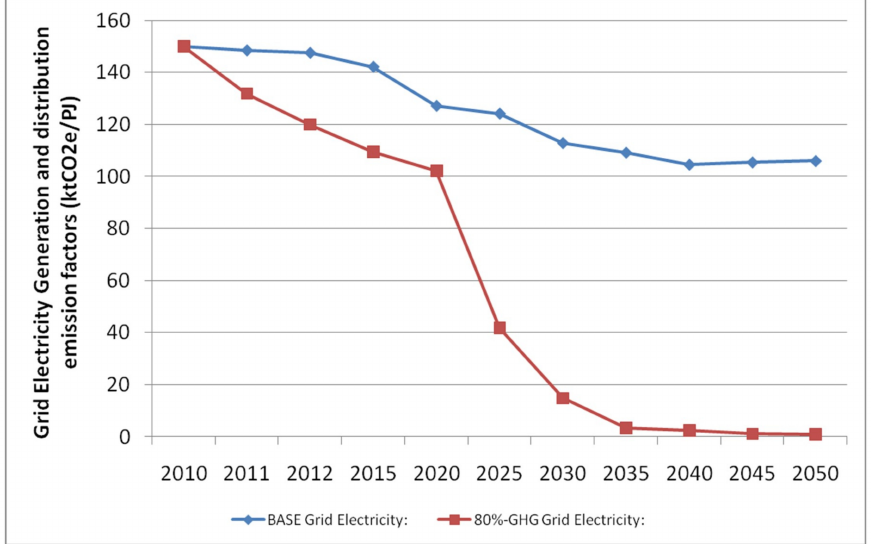
Figure 7. Changes in emission factors from Grid